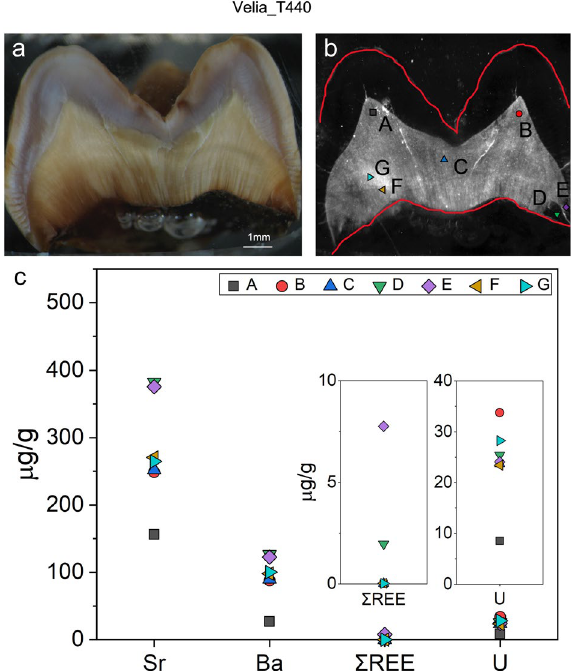
Figure 7. Image of tooth Velia_T440 (1.25 × magnification). ( a ) Optical microscope, ( b ) CL image with points of LA–ICP–MS spot analysis. Bright lines are due to fissures, ( c ) LA–ICP–MS spot analyses (ΣREE, U, Sr, Ba). Error bars (2 SE) are smaller than the symbol size. Two-standard errors are calculated based on repeated measures (n = 9) of NIST SRM 1400 bone ash (Sr: 4 µg/g; Ba: 19 µg/g; U: 0.1 µg/g; ΣREE: 0.35